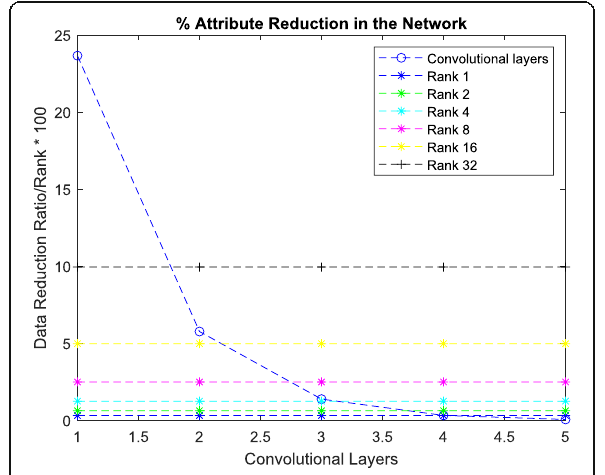
Fig. 3 Attribute Reductions of CPD and CNN Compared